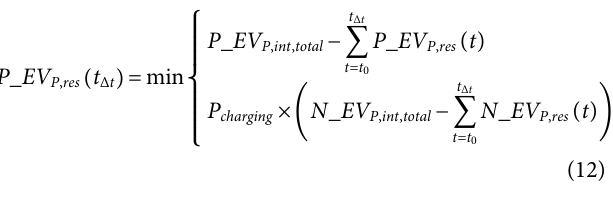
Frontiers in Energy Research |